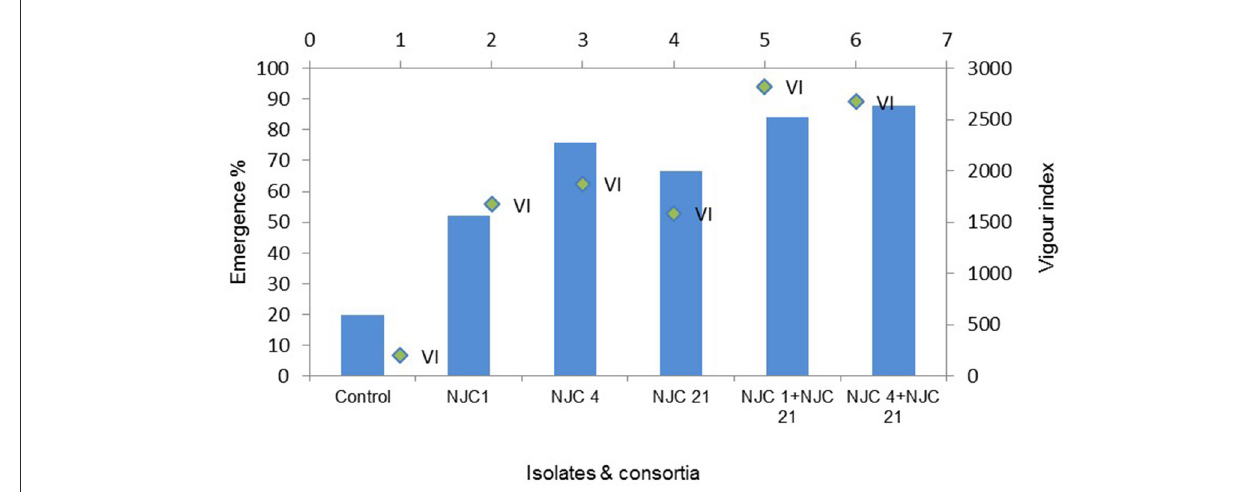
FIGURE8 Emergence percentage and vigor index of Anethum graveolens treated with isolates and consortia.